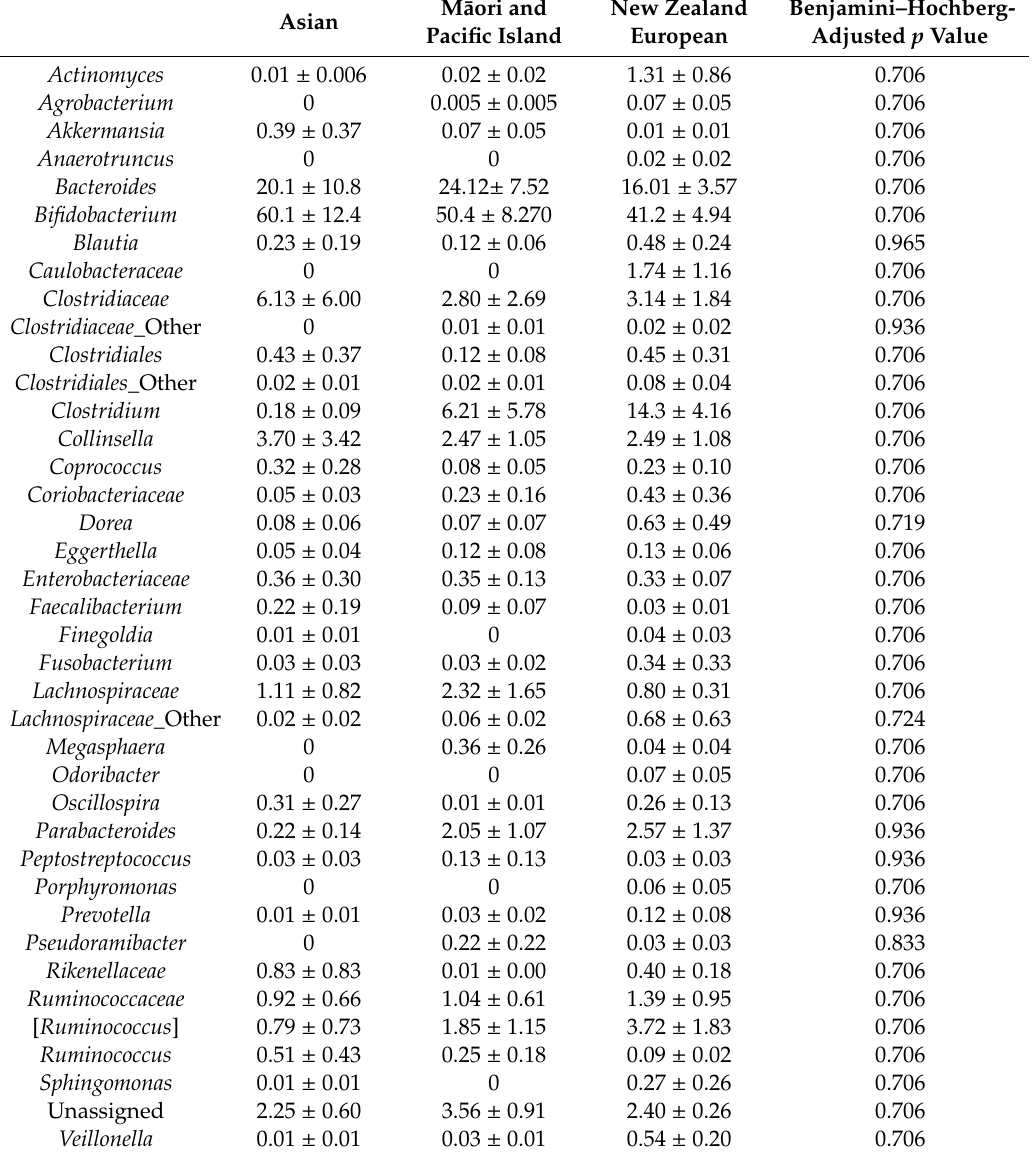
Table 3. Relative abundance of bacteria at the genus level in the infant’s feces categorized according to the mother’s